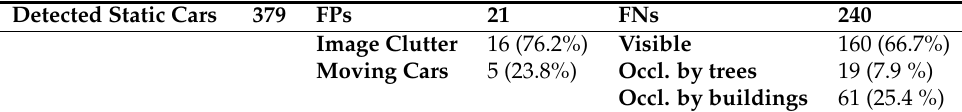
Table 4. Visually examined failure categories for FPs and FNs collected on 14 out of 57 test images.